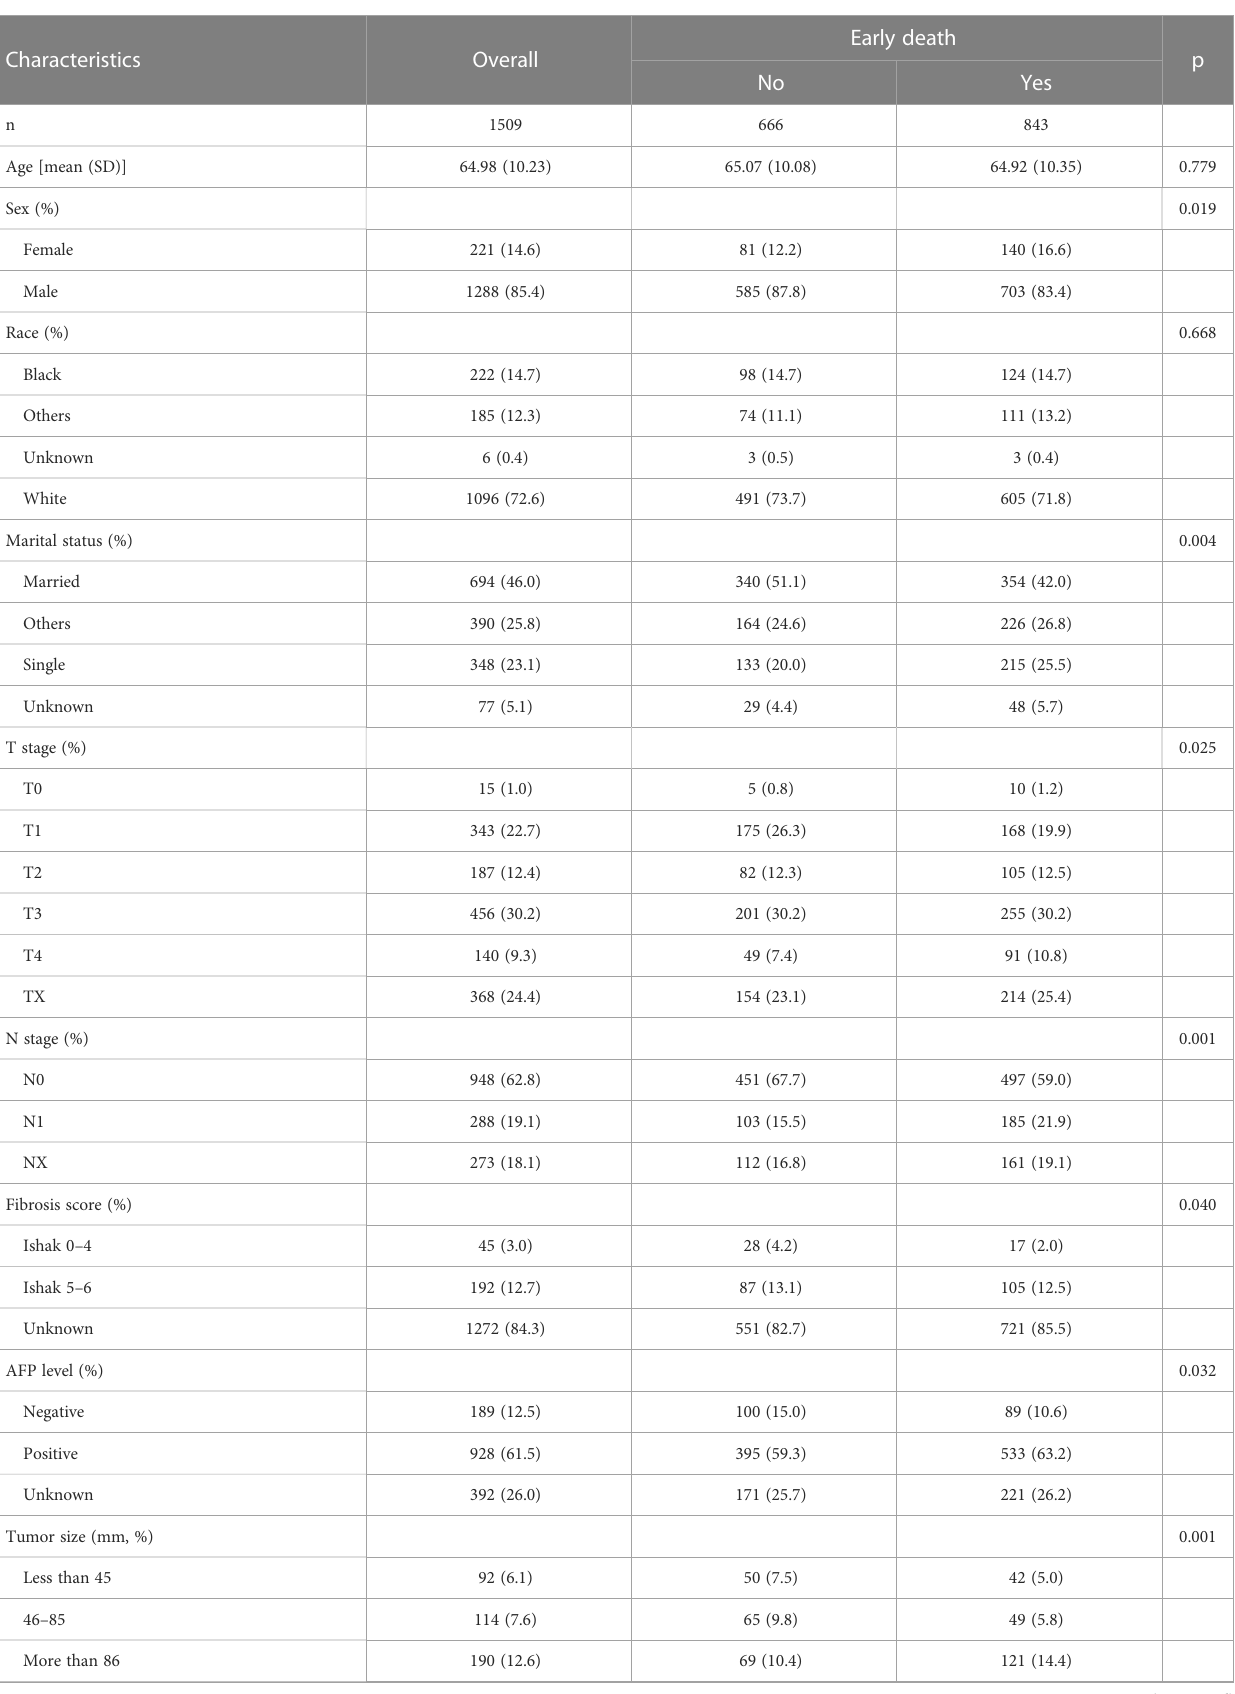
TABLE 3 Clinical characteristics among patients strati fi ed by early death in the training